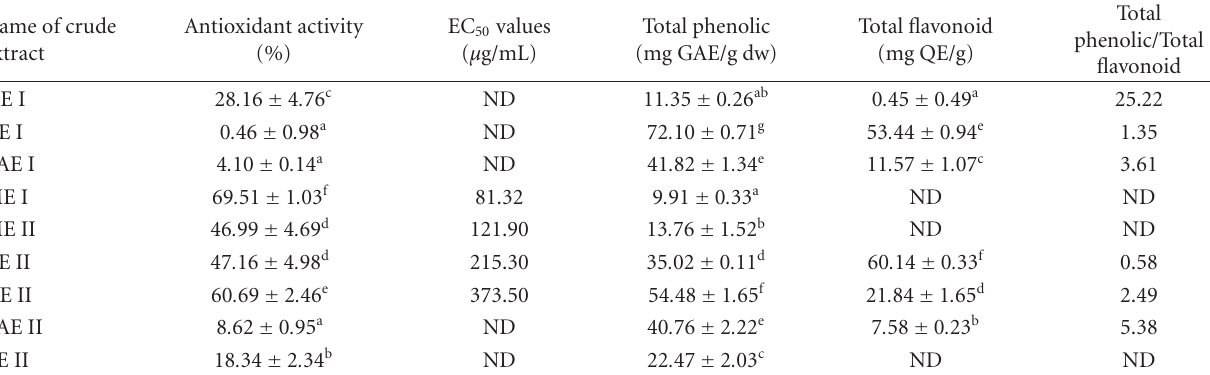
Each value represented the mean ± SD of three replicates ( n = 3). Values with di ff erent letters are significantly di ff erent( P < . 05) based on One Way and Tukey HSD test. Data of total phenolic contents are expressed as milligrams of gallic acid (GAE) equivalents per microgram dry weight. Quercetin and BHT were used as a positive control, EC 50 = 4.95 μ g/mL and 50.31 μ g/mL and the final concentration were 125 μ g/mL. ND = Not determined ∗ Modarresi Chahardehi et al.